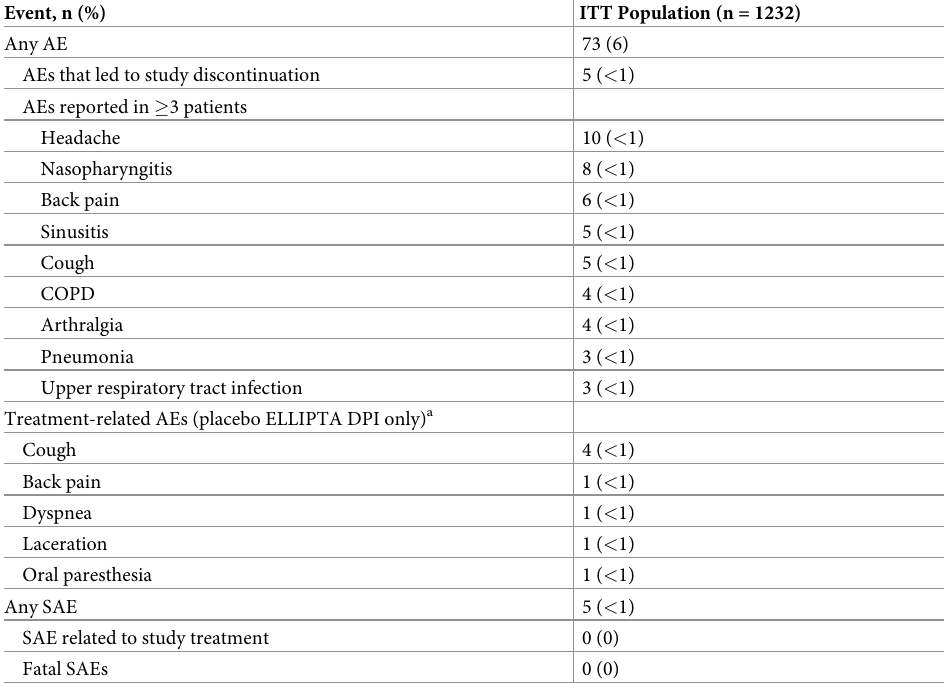
Table 4. Summary of